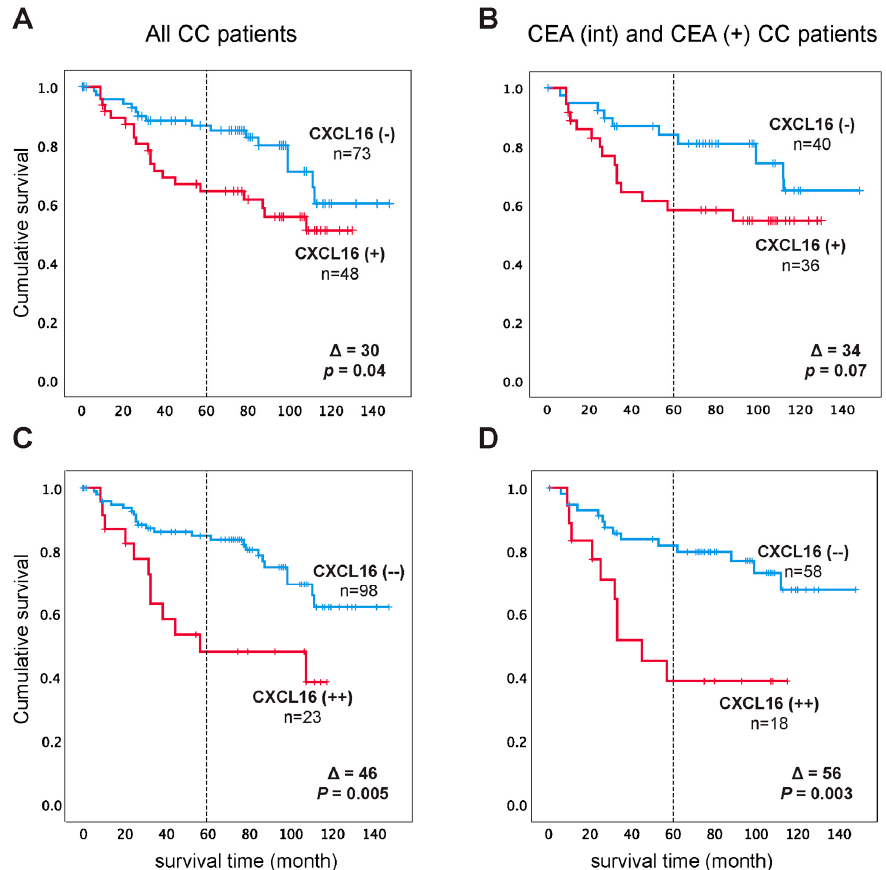
Figure 4. ( A , B ) Kaplan–Meier cumulative survival curves for CC patients divided into two groups CXCL16( − ) and CXCL16(+) according to the median of mRNA expression in the highest lymph nodes in the CC patients in TNM stages III and IV (7.2 mRNA copies/ 18S rRNA unit). In ( B ) the Kaplan–Meier cumulative survival curves for CXCL16(-) and CXCL16(+) patients are restricted to the CEA(+) plus CEA(int) subgroup of CC patients. ( C , D ) Kaplan–Meier cumulative survival curves for CC patients divided into two groups CXCL16(--) and CXCL16(++) according to the median of mRNA expression in lymph nodes from CC patients in the CEA(+) group (11.4 mRNA copies/ 18S rRNA unit). In ( D ) the Kaplan–Meier cumulative survival curves for CXCL16(--) and CXCL16(++) patients are restricted to the CEA(+) plus CEA(int) subgroup of CC patients. The patients were followed for 12 years. Differences in disease-free survival time after surgery between the two groups are given as a ∆ -value in months and statistical significance as P-values. n = number of patients in the respective group.